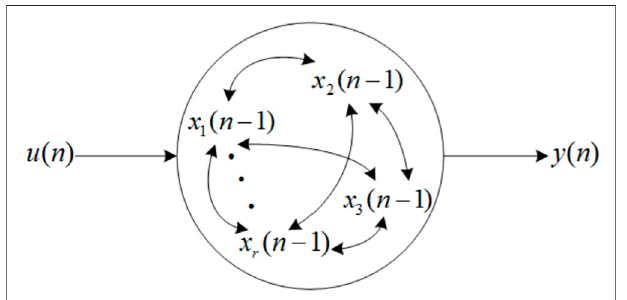
FIGURE 2 | Full connection of internal units in a reservoir.